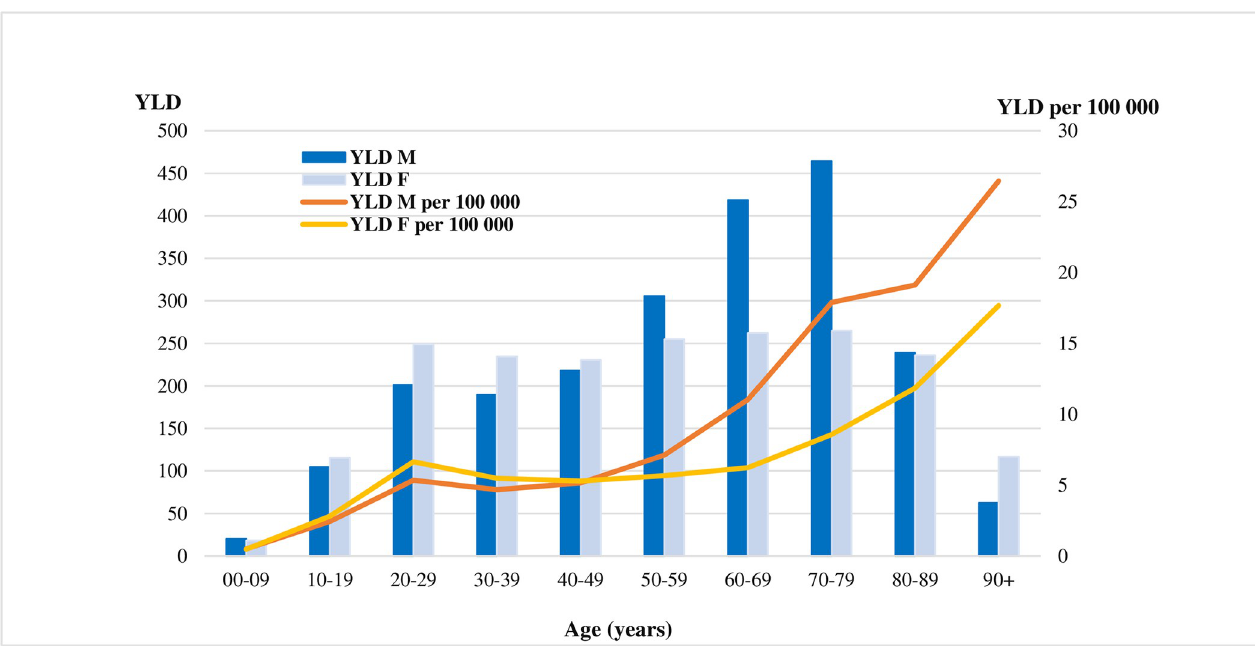
Fig 2. Years lived with disability due to acute symptomatic COVID-19 infections in France in 2020 by age and sex.